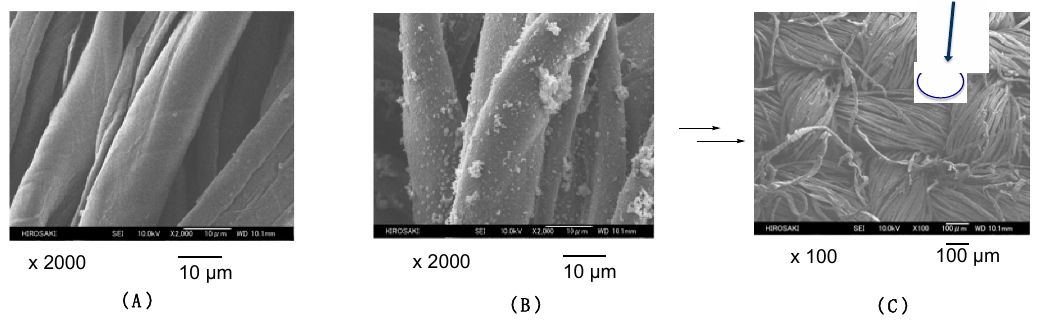
Figure 3. SEM pictures of pristine cotton swatch ( A ), the modified cotton watch with R F -VMSiO 2 /TAZ composites (Run 1 in Table 2) ( B , C ).